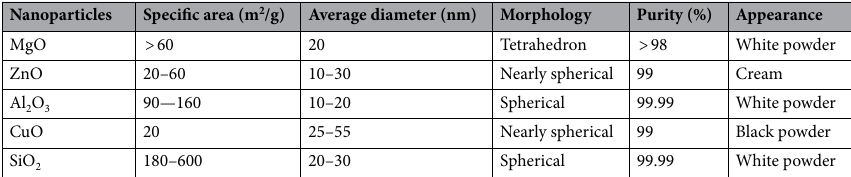
Table 3. The characteristics of metal oxide NPs used in this study.